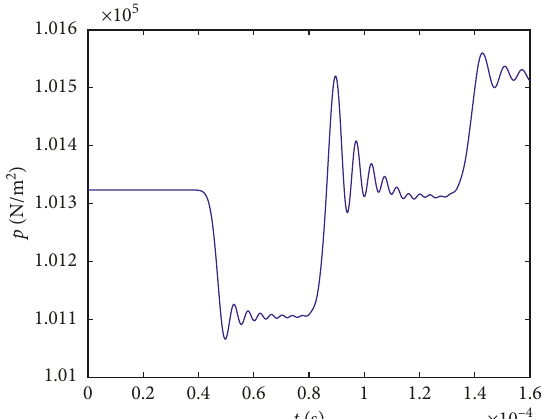
Figure 4: Fluid pressure at the point A versus time, reprinted from [11], copyright 2017 with permission from Springer Nature.